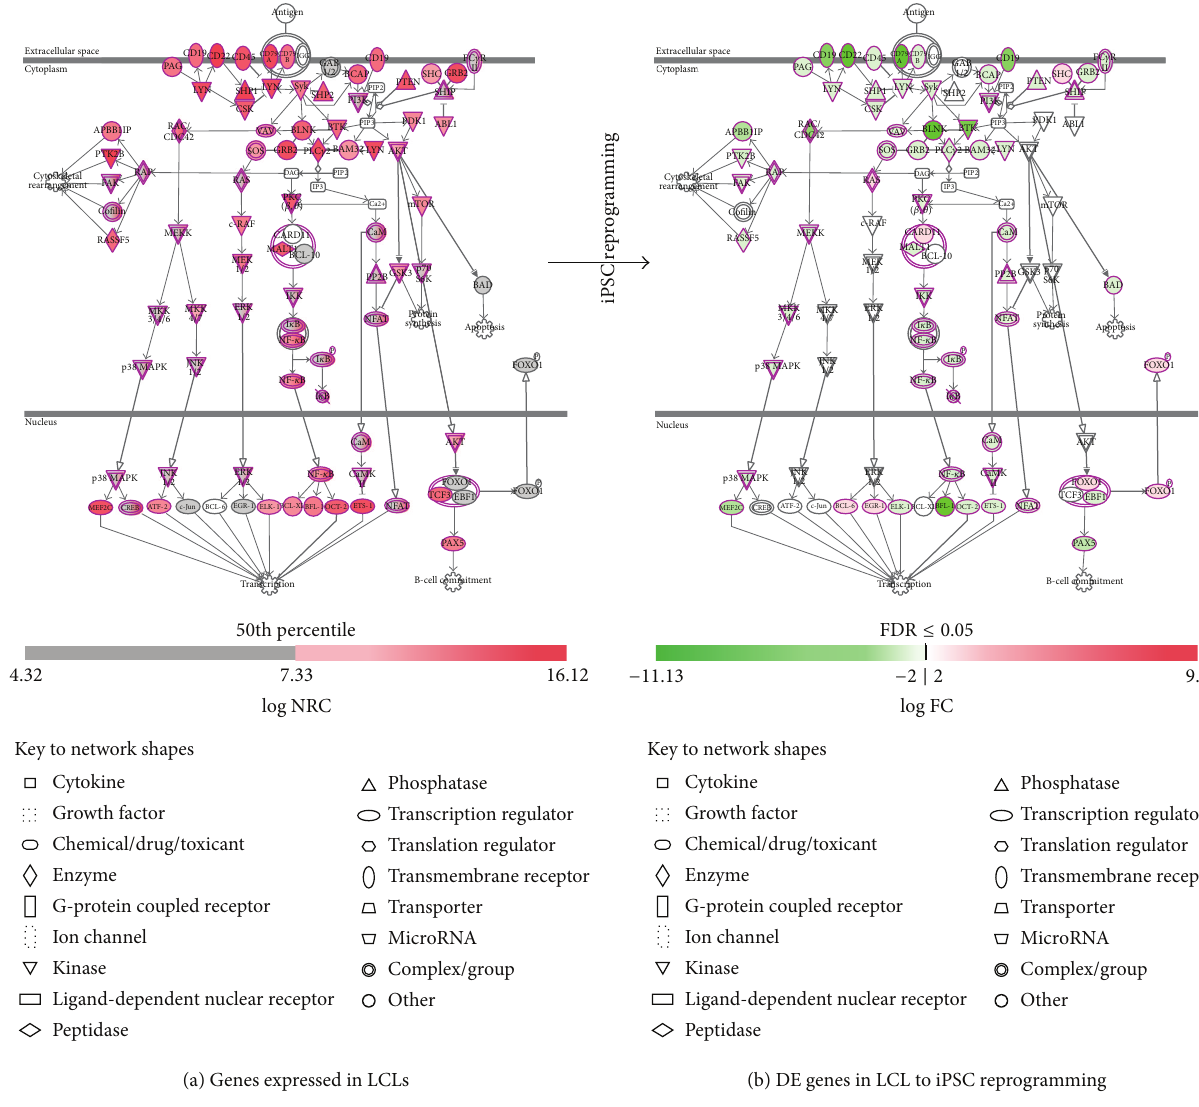
Figure 6: Diagram showing key LCL specific canonical pathways. (a) Pathway genes expressed in LCLs. (b) Differential expression of pathway genes during LCL-to-iPSC